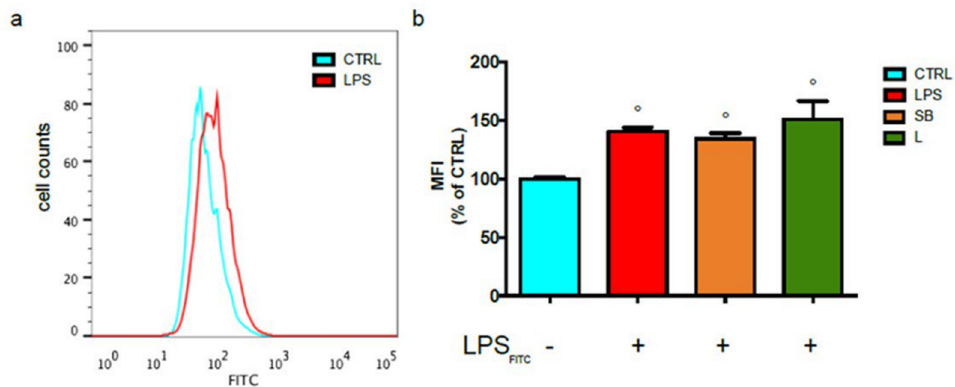
Figure 1. Analysis of LPS binding to BV-2 cells after treatment with chestnut leaf or spiny bur ex- tracts. BV-2 cells were pre-treated (or not) with spiny bur (SB) or leaf (L) extracts (0.5 mg/mL) for 3 h, then incubated with 0.5 μ g/mL LPS-FITC for a total of 24 h. The fluorescence of bound LPS was evaluated by flow cytometric analysis of live cells. ( a ) Representative plot of untreated controls and LPS-treated cells ( b ) Relative quantification is expressed as MFI, the median fluorescence intensity. Results are expressed as means ± SEM of three independent experiments. Statistical analysis was performed by Fisher’s LSD test following one-way ANOVA. ° p < 0.05 significantly different from control cells.